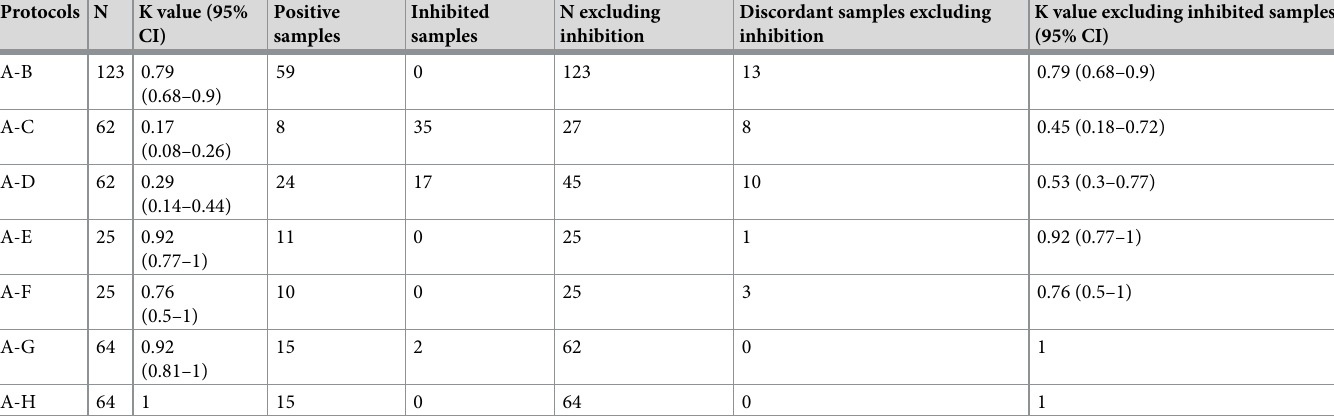
N: number of samples assessed in parallel by both protocols compared. Positive samples: number of samples with a positive result for both protocols. Inhibited samples: number of samples with an invalid result for the internal amplification control (IAC) in at least one of the two protocols compared. CI: confidence